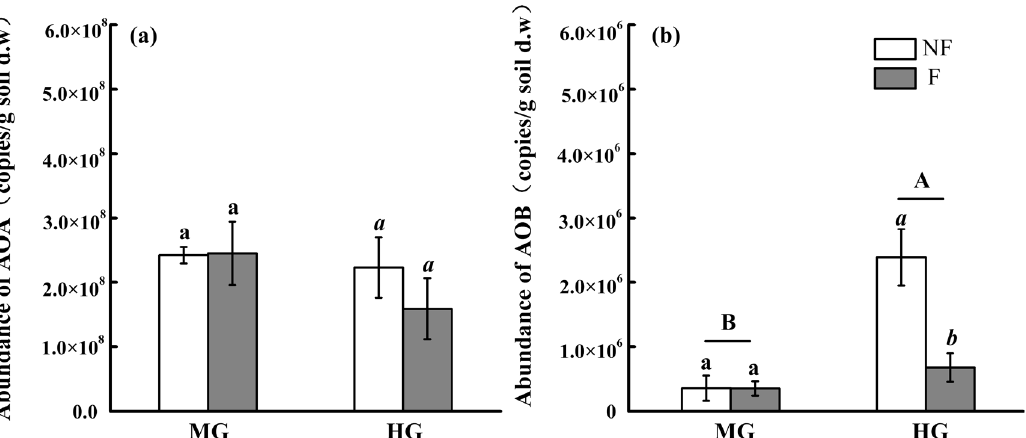
Figure 2. Effects of grazing intensity and enclosure on the abundance of AOA ( a ) and AOB ( b ) in soil. MG moderately grazed site, HG heavily grazed site, NF non-fenced, F fenced treatment. Different lowercase letters indicate differences between NF and F treatment at the MG and HG sites, respectively ( p < 0.05, n = 4). Different capital letters indicate differences between the MG and HG sites across NF and F treatment ( p < 0.05, n =